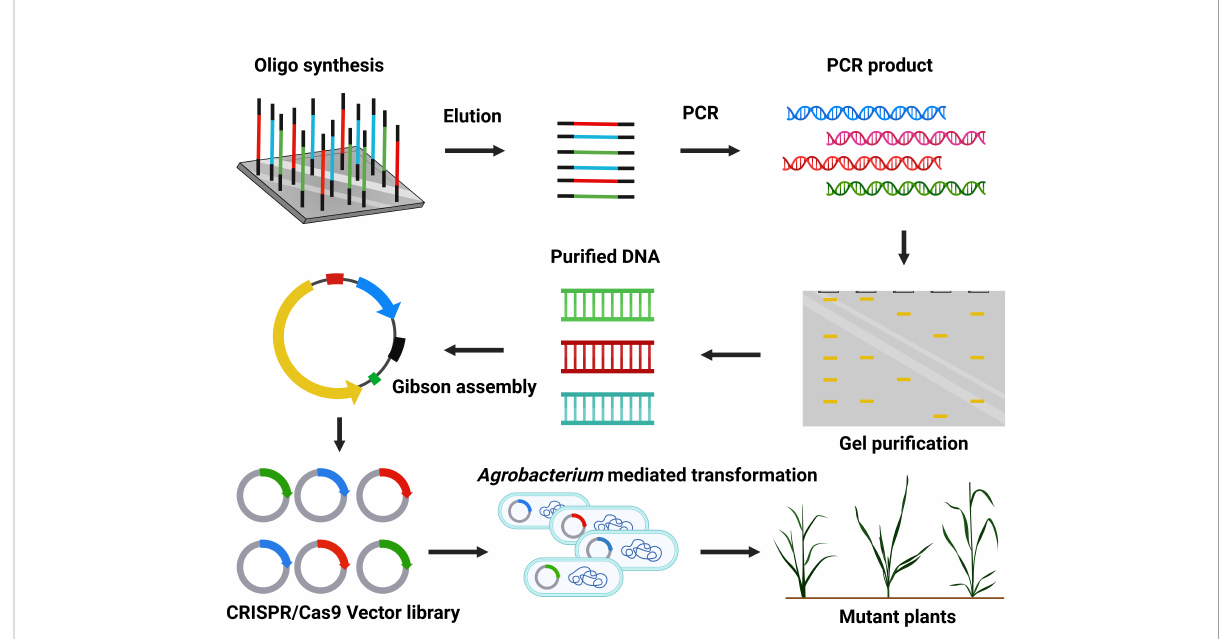
FIGURE 5 Construction of CRISPR/Cas9-mediated mutant library.